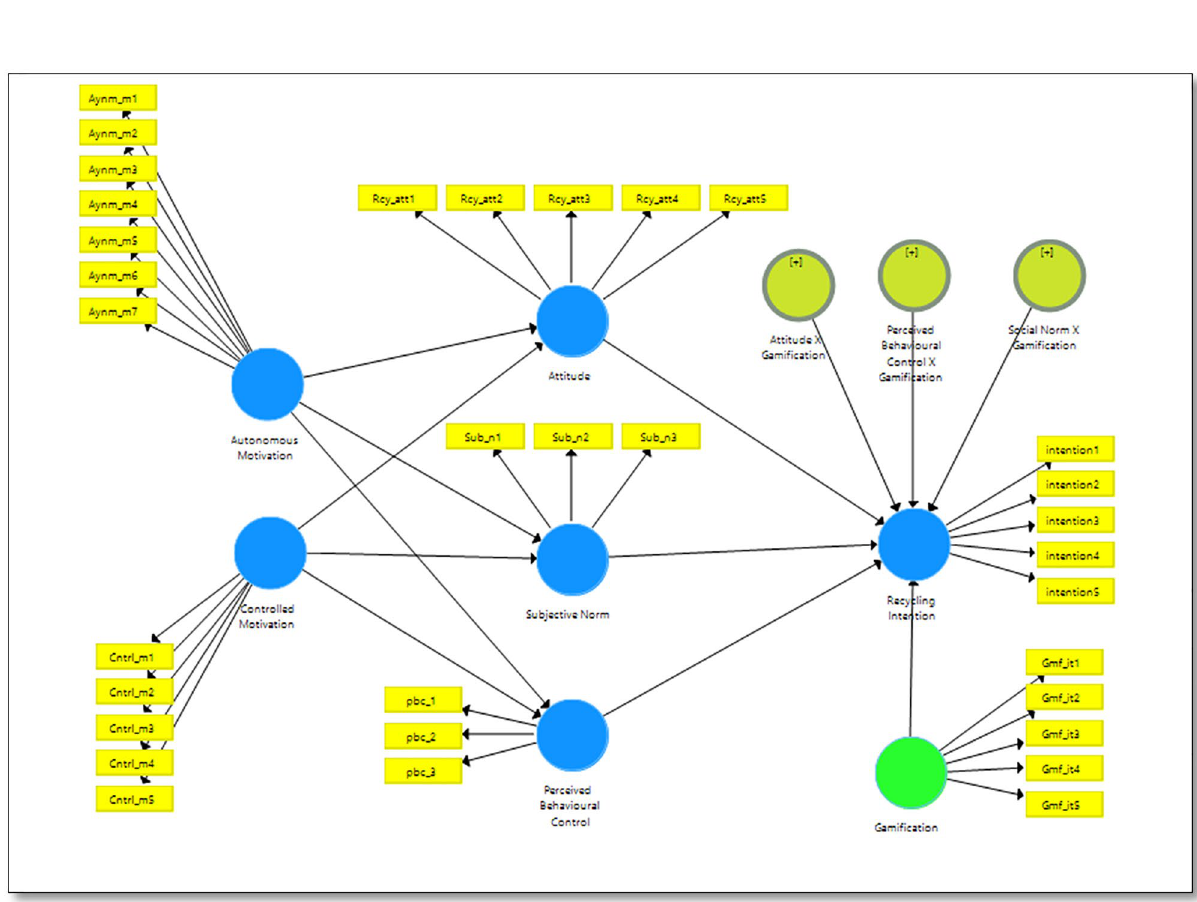
Figure 3. Research structural model from